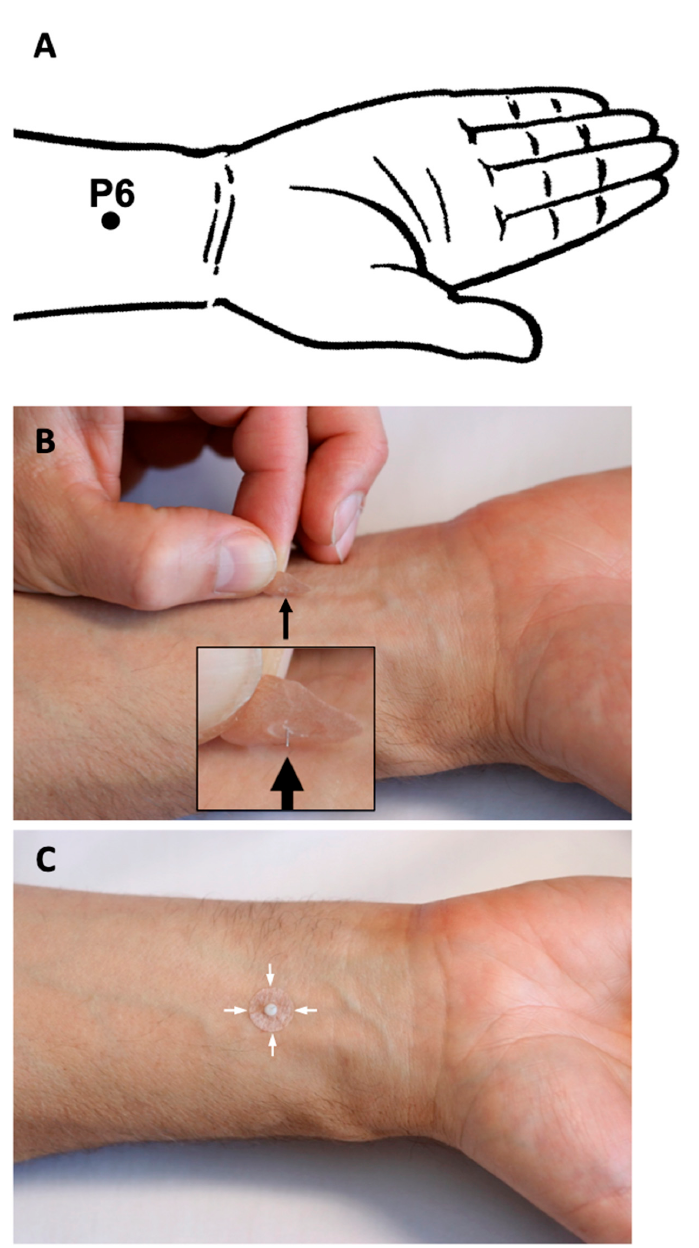
Figure 2. ( A ) Acupoint Neuguan PC6 is situated on the medial side of the lower arm between the tendons of M. flexor carpi radialis and M. palmaris longus 3–4 cm over the wrist crease; ( B ) disposable indwelling acupuncture New Pyonex needle (black arrow) with a diameter 0.2 and length 1.5 mm, embedded in skin-colored adhesive tape, over the acupoint PC6. ( C ) New Pyonex needle in situ. White plastic hemisphere is seen over the round adhesive tape (white arrows).